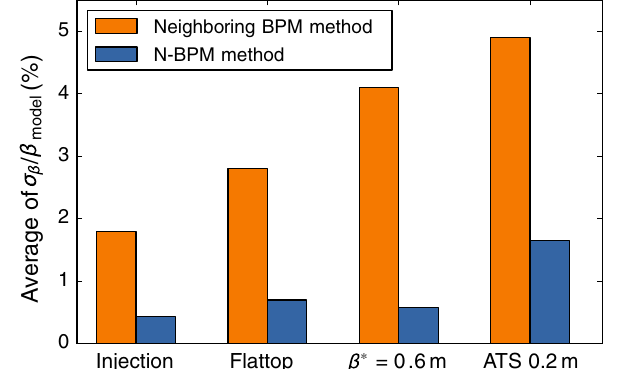
FIG. 6. Comparison between the 3-BPM (also called neighbor- ing BPM) and N-BPM methods in the LHC [91]. The average error bar of the experimentally measured beta function for different optics configuration at 4 TeV, except for injection at 0.45